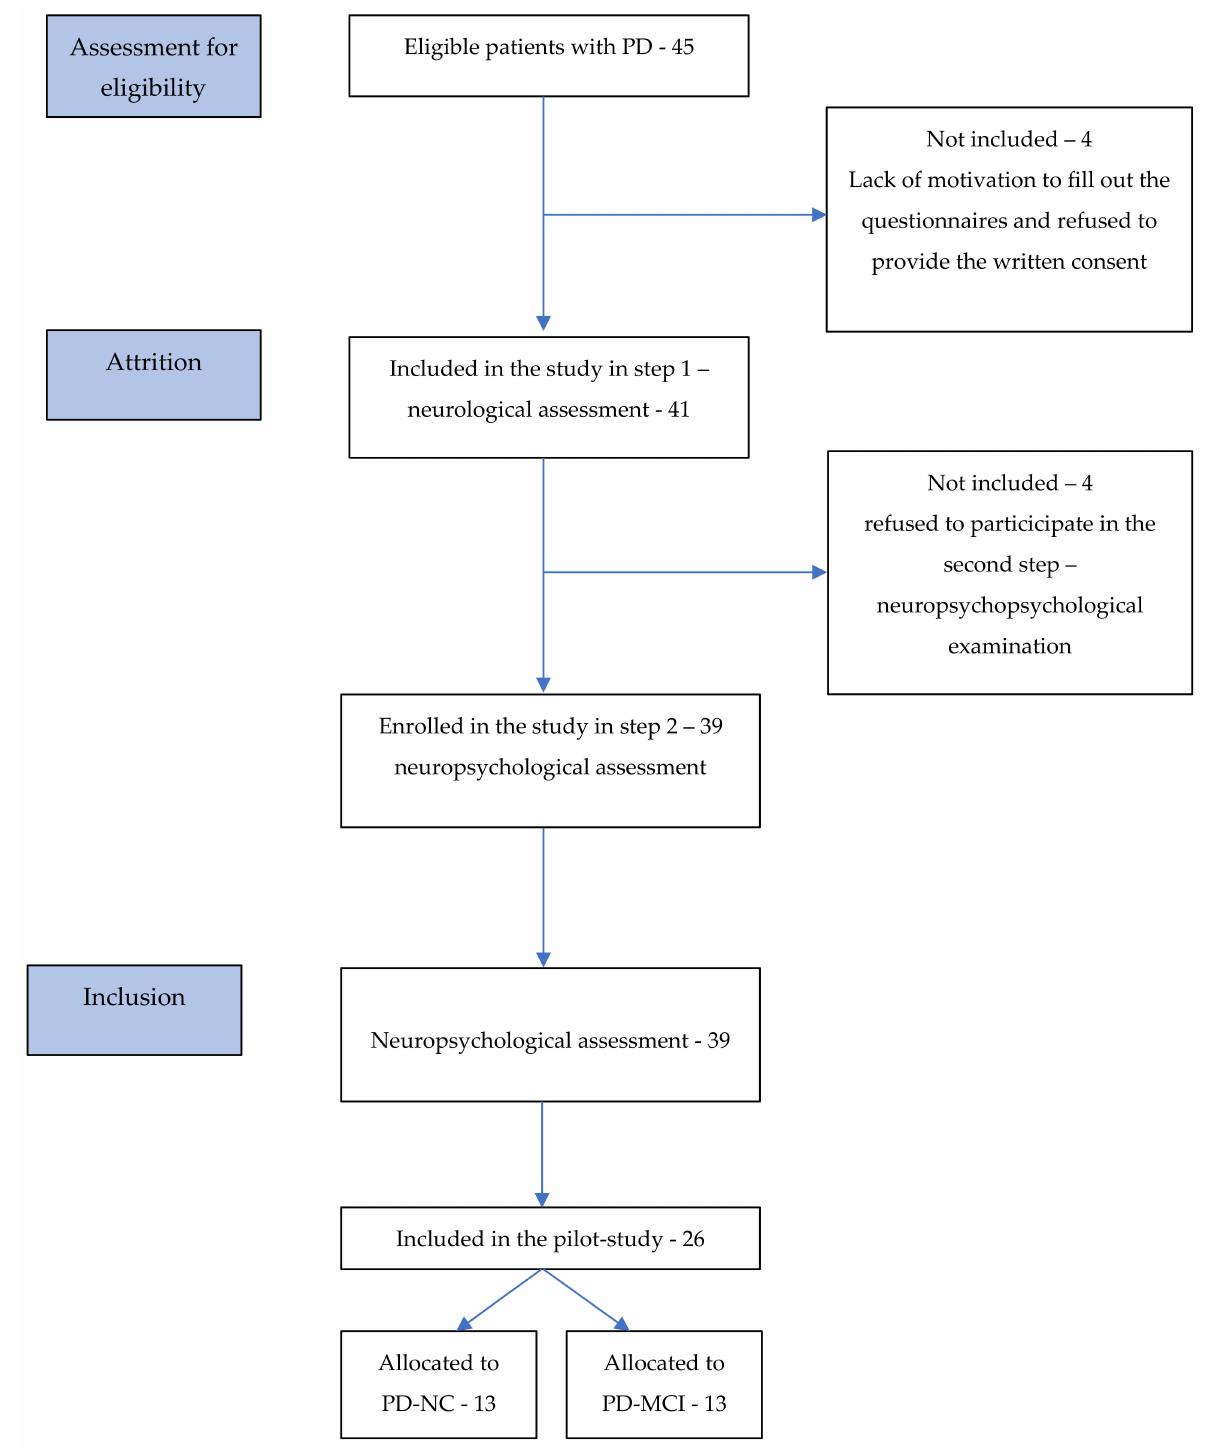
Figure 1. Flowchart showing how participants were recruited to the clinical group throughout the recruitment and study